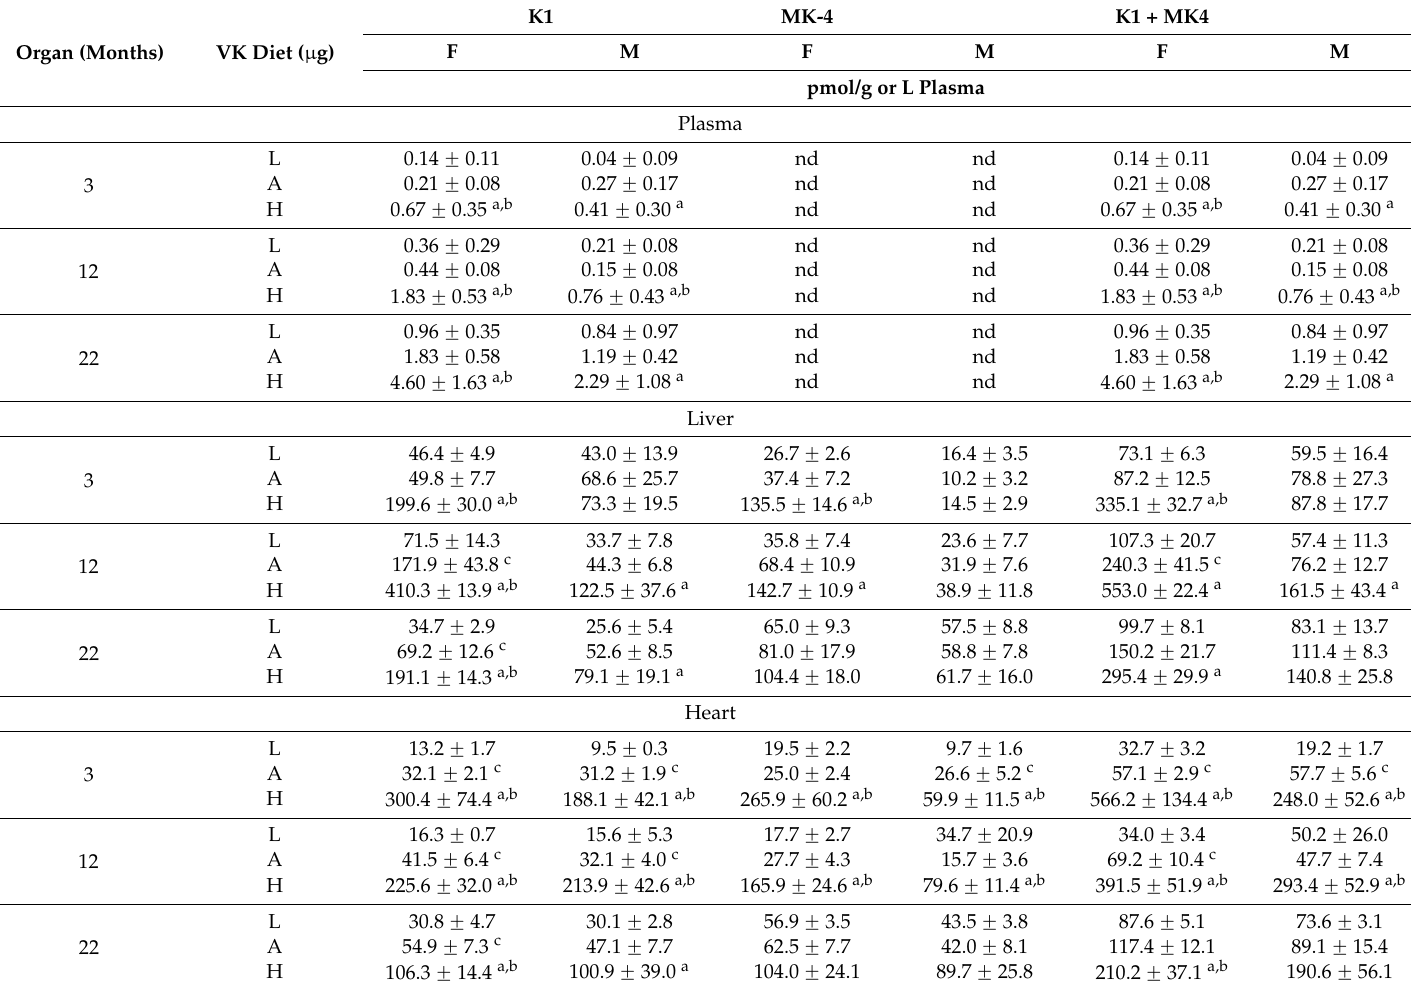
Table 2. Plasma and tissue (liver, heart, kidneys, spleen, brain, ovaries and testes) K 1 , MK-4 and total (K 1 + MK-4) vitamin K (VK) concentrations of 3-, 12-, and 22-month-old M and F Sprague–Dawley rats fed the L, A or H diets throughout their